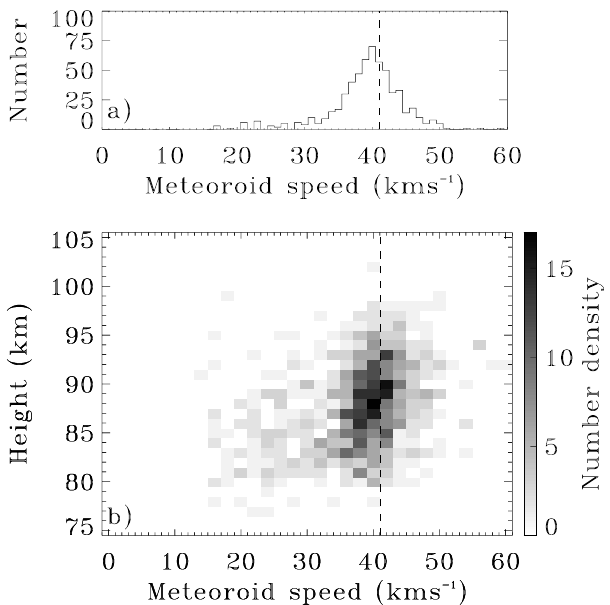
Fig. 9. Results of the application of Fresnel transform speed estima- tion to meteor echoes identified as Southern delta-Aquarid shower meteors using the radiant mapping procedure for data collected by the Davis meteor radar on 27 July 2005: (a) speed distribution, (b) speed versus height distribution. The dashed line indicates the the- oretical pre-atmospheric entrance speed of Southern delta-Aquarid shower meteoroids (41kms − 1